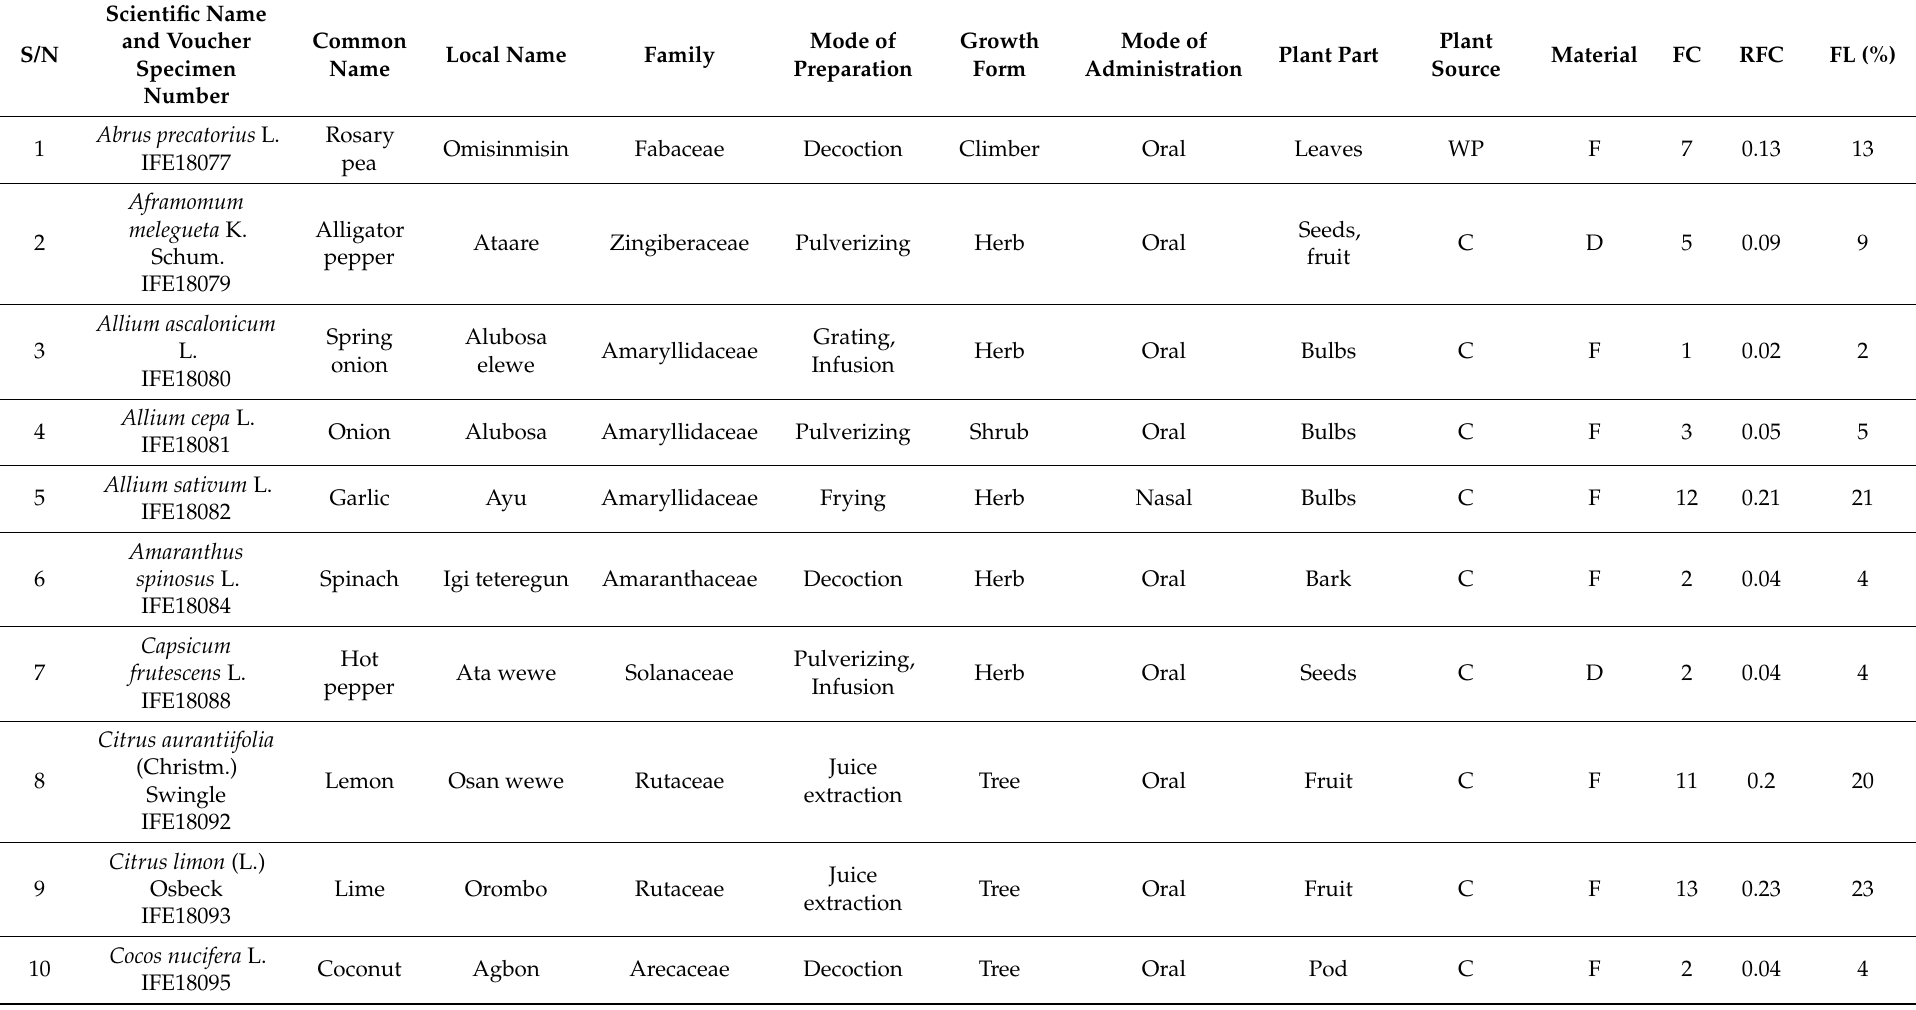
Table 3. Medicinal plants used to treat and prevent cough in Ogbomosho North and South Local Government Areas, Oyo State,